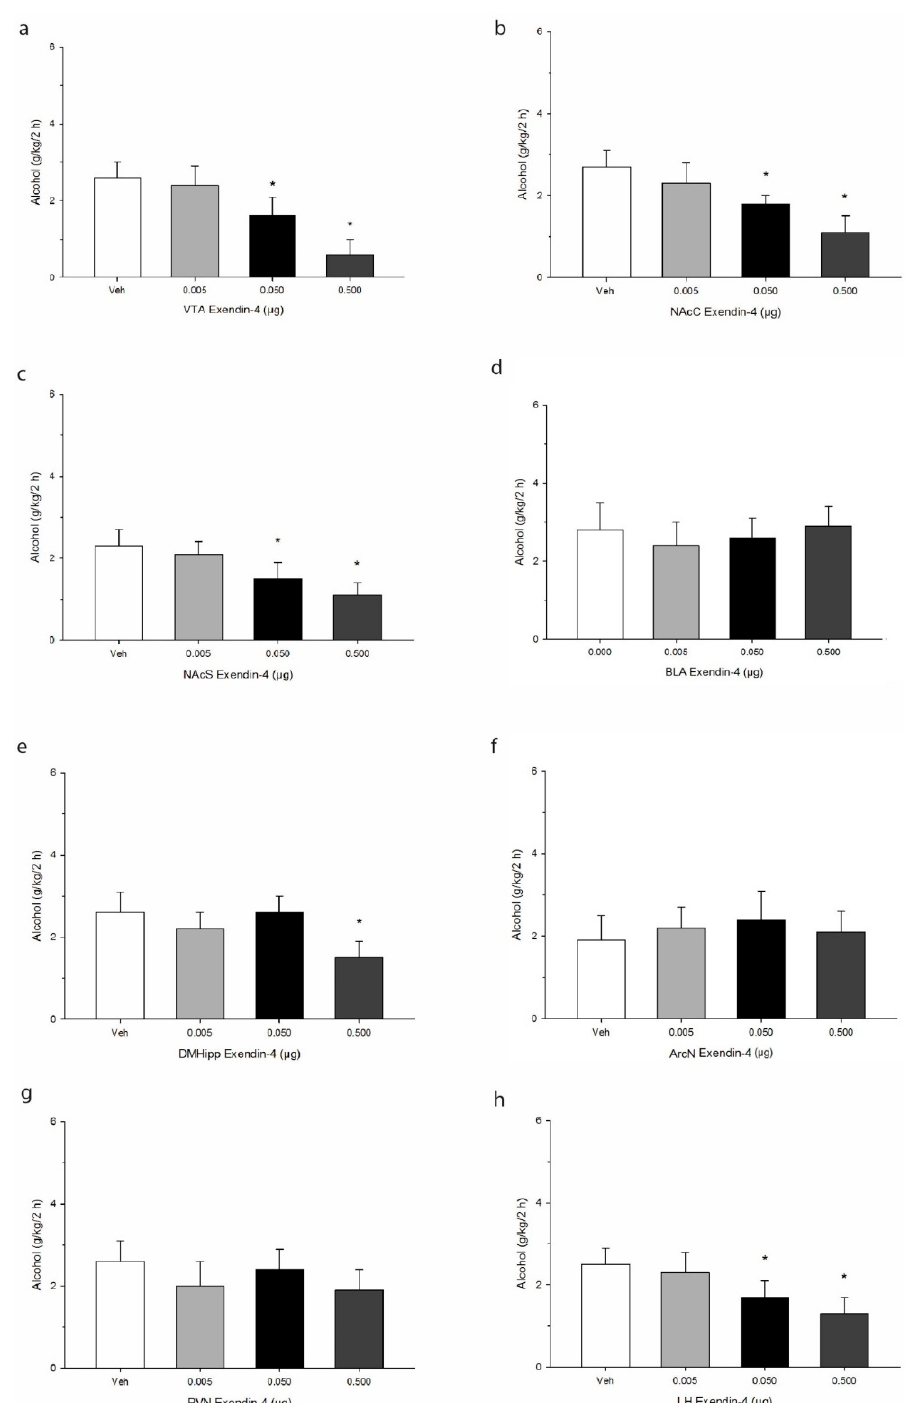
Figure 2. Effects of microinjection of Ex-4 on alcohol intake over a 2 h period in the early nocturnal cycle. Treatment was delivered into primary regions of the mesolimbic system, including (a) the ventral tegmental area (VTA), (b) the nucleus accumbens core (NAcC), and (c) the nucleus accumbens shell (NAcS). Injections were also administered into (d) the basolateral amygdala, (e) the dorsomedial hippocampus (DMHipp), and discrete regions of the hypothalamus, specifically (f) the arcuate nucleus (ArcN), (g) the paraventricular nucleus (PVN), and (h) the lateral hypothalamus (LH). Values represent mean alcohol intake +/- SEM. * p < 0.05 compared to Veh; n = 8/site.